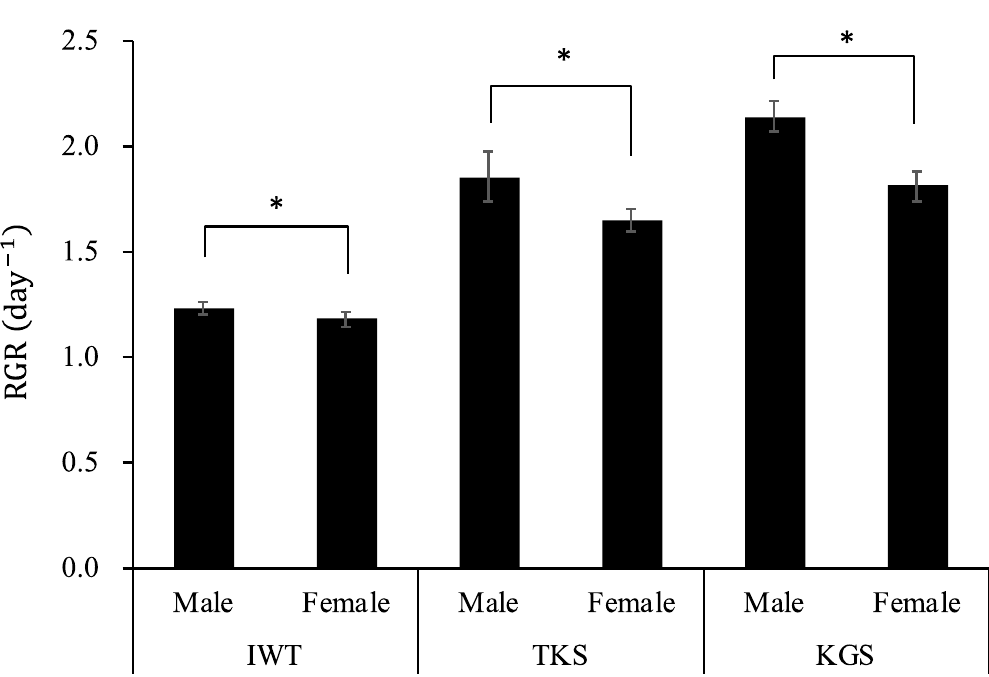
Figure 4. Comparison of relative growth rates (RGR) of male and female gametophytes of Undaria pinnatifida for the three regional lines cultivated under optimum temperature, light intensity, and wavelength. Values are expressed as mean ± SE ( n = 24). * indicates significant differences among the means of males and females ( t -test, p < 0.05). IWT—Iwate, TKS—Tokushima, KGS—Kagoshima. Table 4. The temperature, light intensity, and light wavelength for optimal growth of male and female gametophytes for Iwate (IWT), Tokushima (TKS), and Kagoshima (KGS) lines, as predicted by response surface methodology.